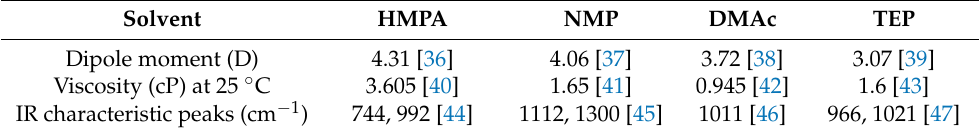
Table 1. Properties of the solvents used to dissolve PVDF. Solvent HMPA NMP DMAc TEP Dipole moment (D) 4.31 [36] Viscosity (cP) at 25 ◦ C IR characteristic peaks (cm − 1